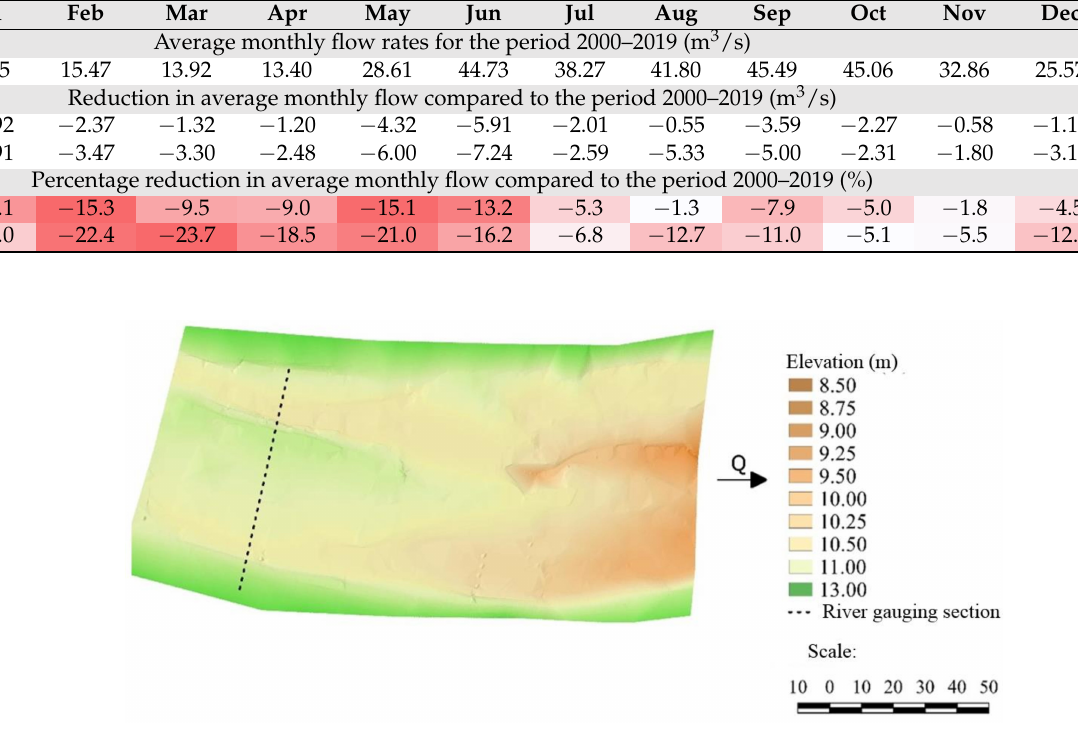
Figure 8. Elevation model of the channel path under study.